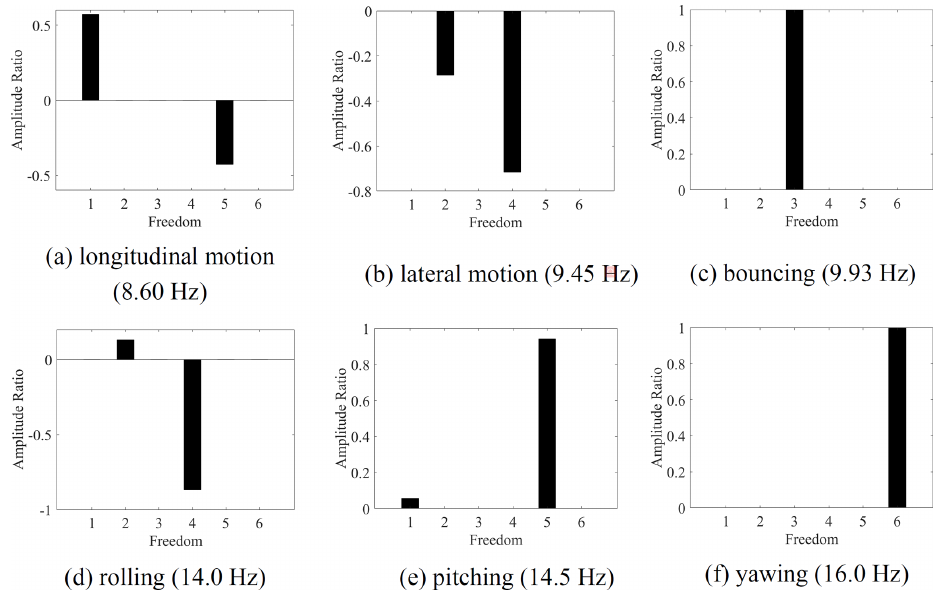
Figure 2. Vibration shapes of the main